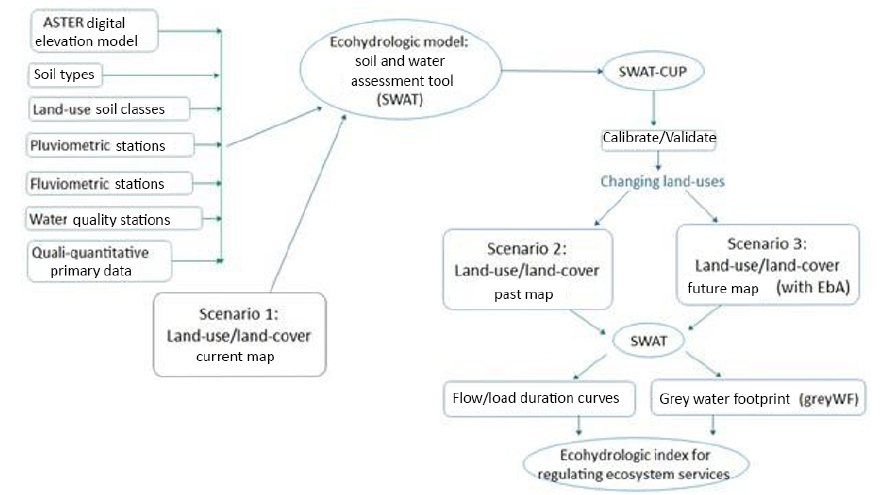
Figure 2. Methodological scheme for assessing hydrologic services based on